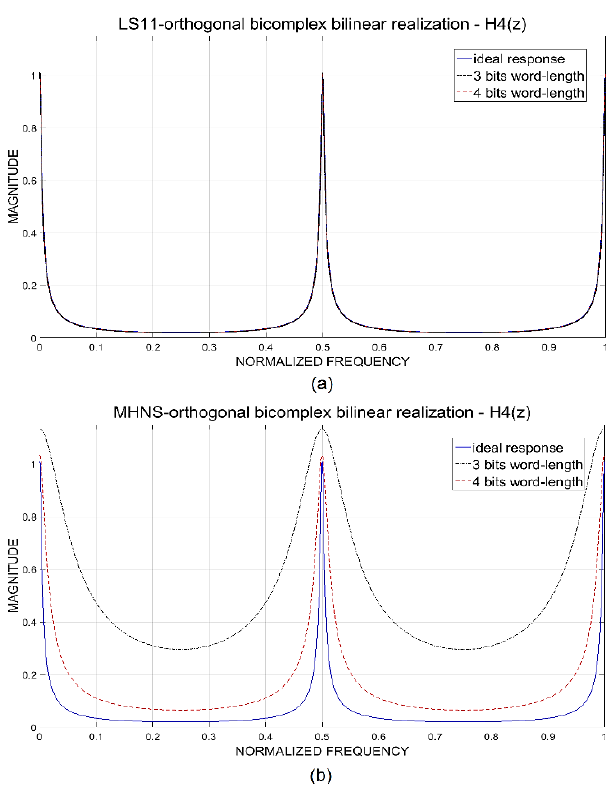
Fig. 11. Magnitude responses of the bicomplex orthogonal real-coefficient functions H 4 ( z ) for different word-lengths: (a) LS 11-based; (b) MHNS -based. transfer function with complex or real coefficients. This